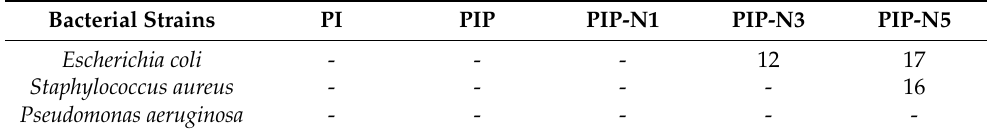
Table 3. Antibacterial efficiency of the